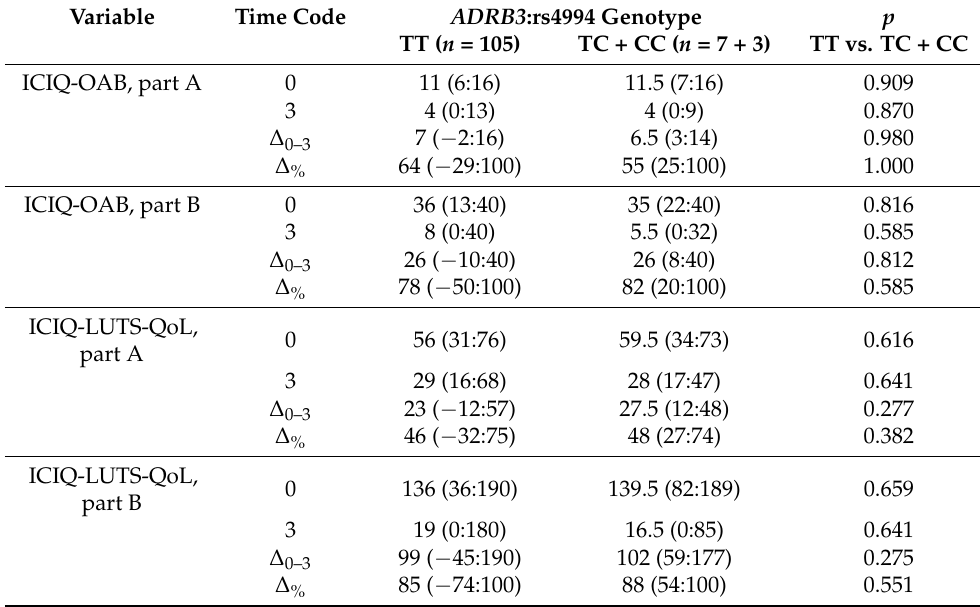
Table 3. ICIQ-OAB and ICIQ-LUTSqol questionnaire scores from women with overactive bladder, be- fore and three months after intra-detrusor injection of botulinum toxin-A, in regard to ADRB3 :rs4994